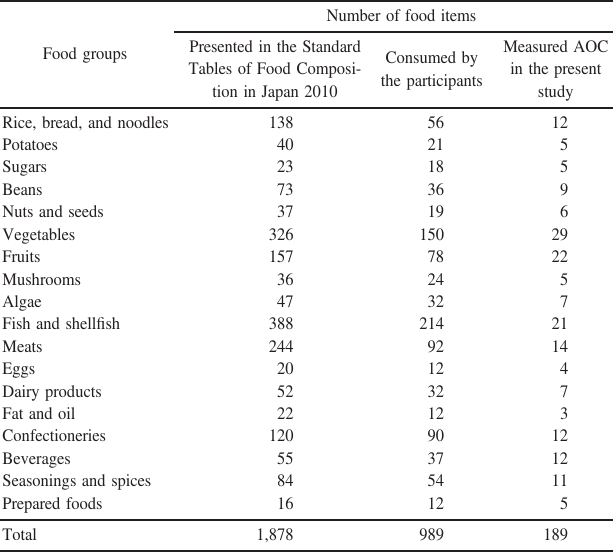
Table 1. Number of food items consumed by participants and measured antioxidant capacity in the present